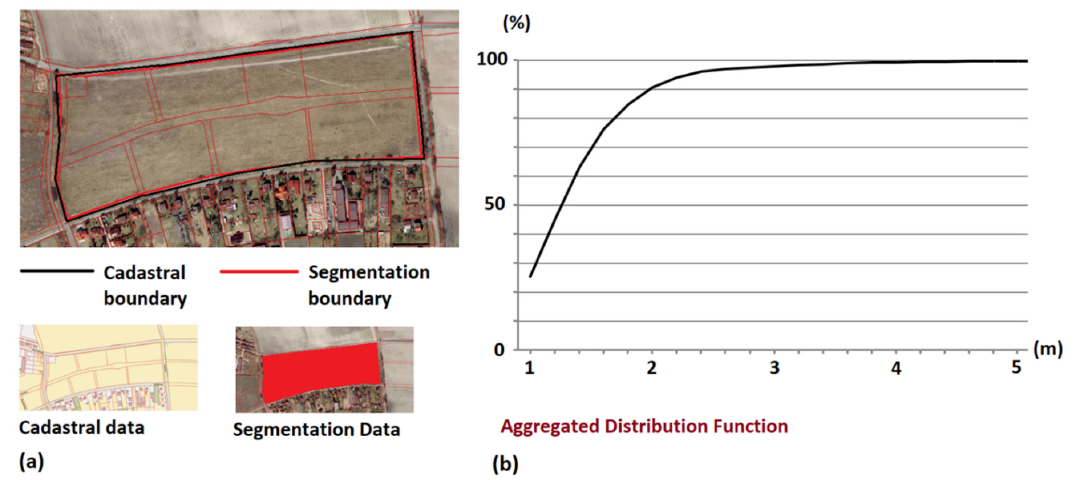
Figure 9. ( a ) Single buffer overlay method (SBOM) adapted to the line-closed case: the cadastral boundary represents the line of the source of greater accuracy (Q), and the segmentation boundary represents the controlled line (X); ( b ) aggregated distribution function.